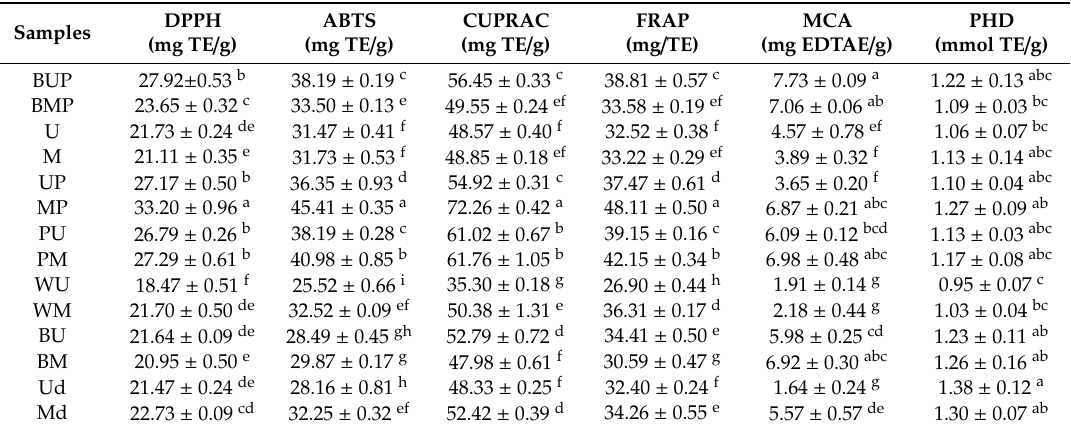
Table 5. Antioxidant properties of the strawberry samples